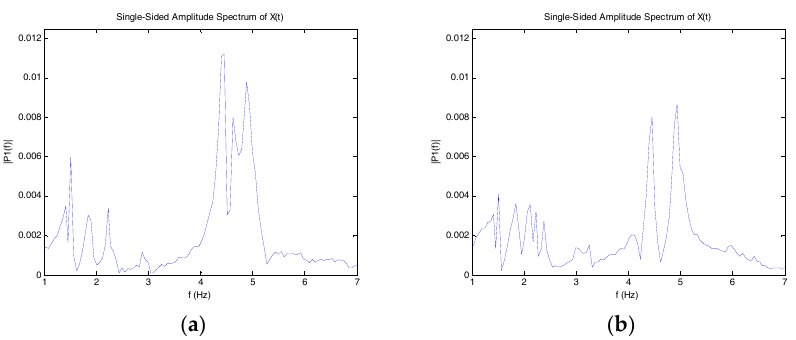
Figure 8. Fast Fourier transform (FFT) of tiltmeter reading. ( a ) Tiltmeter 1 reading; ( b ) Tiltmeter 2 reading.